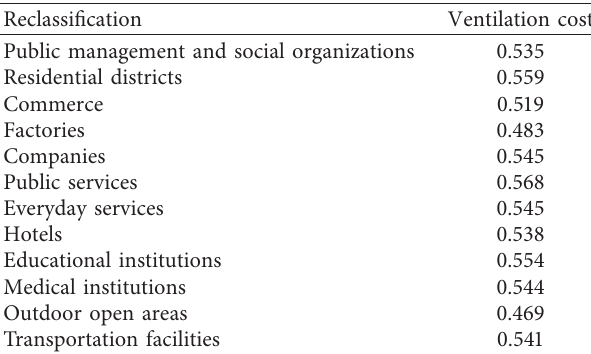
Table 5: Urban functional units and average ventilation costs.